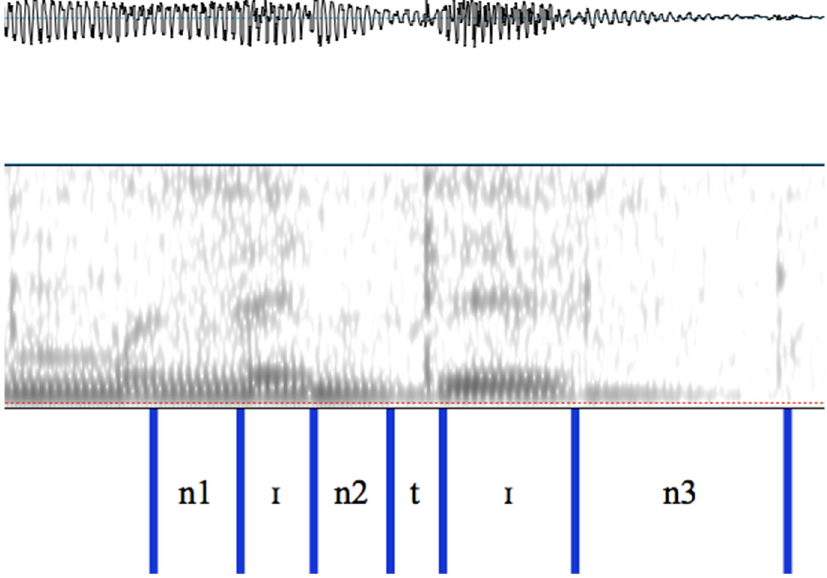
Figure 2. Example of denasalization by younger speaker DM (ninti-nu ‘teach- PST ’) (SW20190331-10-EggStory).